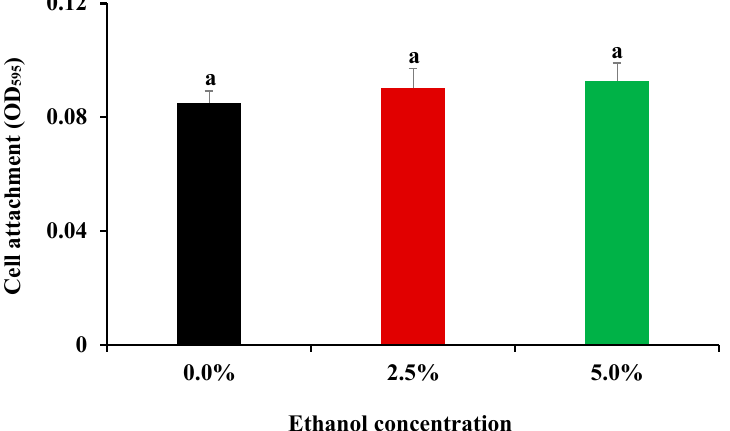
Figure 2. Influence of subinhibitory concentrations of ethanol (1/4 MIC, 2.5%; 1/2 MIC, 5.0%) on cell attachment of S . Enteritidis. The same letters above vertical bars represent no significant difference ( p > 0.05).